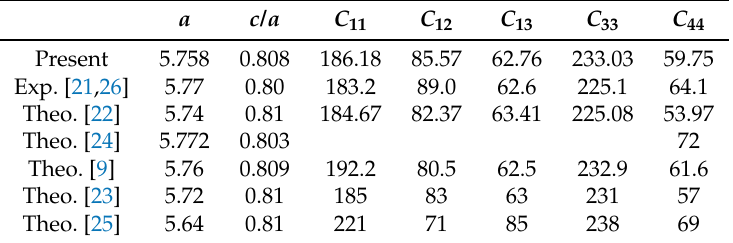
Table 1. The optimized lattice parameters a (in Å), c / a , and elastic constants (in GPa) of Ti 3 Al at zero pressure.